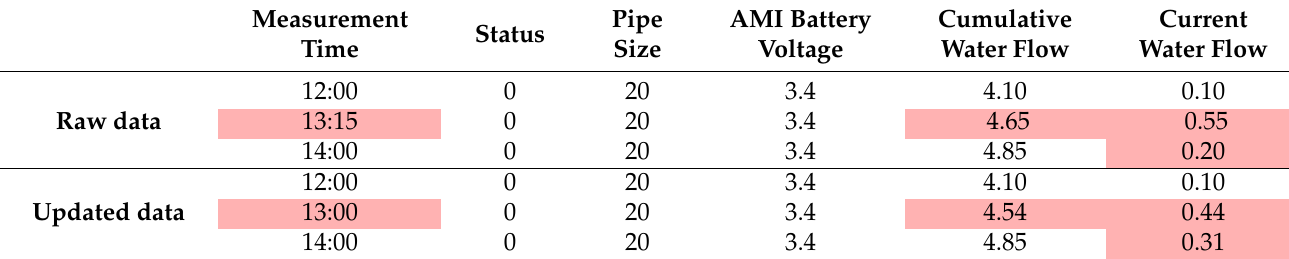
Table 2. Example of data alignment. The colored AMI data is updated using the proposed data alignment methods. Measurement